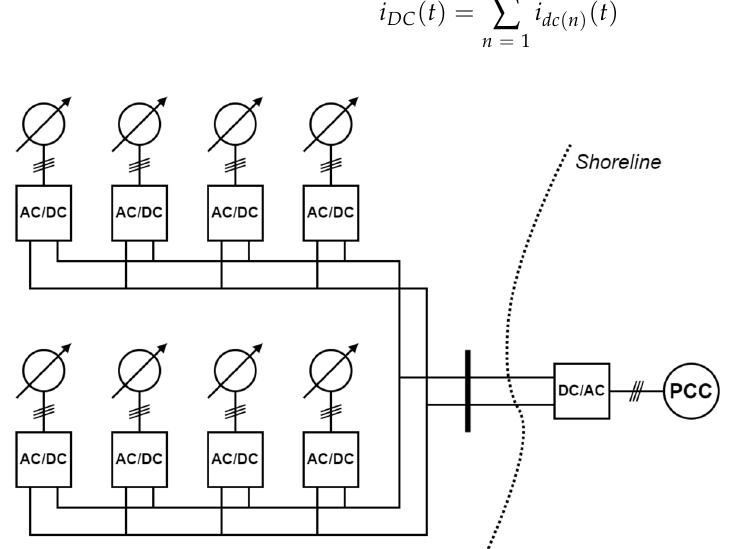
Figure 7. Parallel DC collection grid with an offshore connection point.